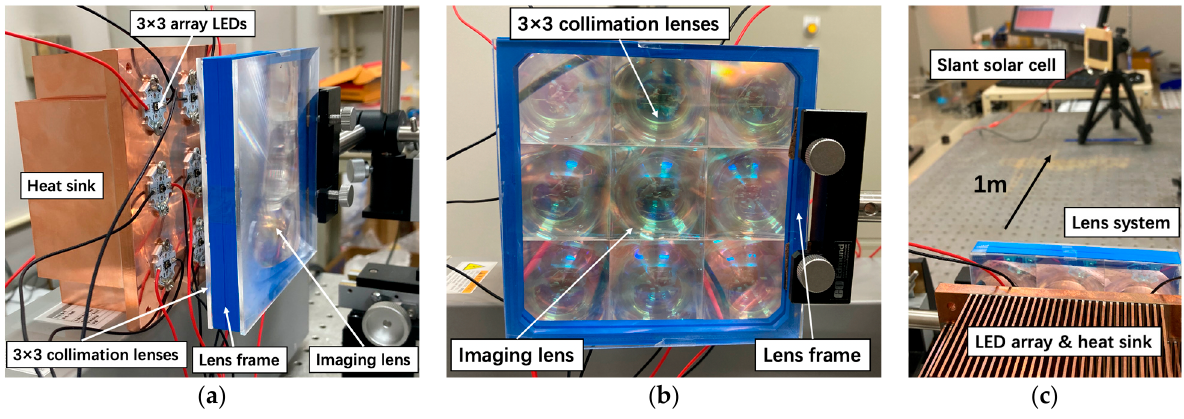
Figure 6. ( a ) View from the side of 3 × 3 LEDs array OWPT; ( b ) lens system; ( c ) experiment set up.